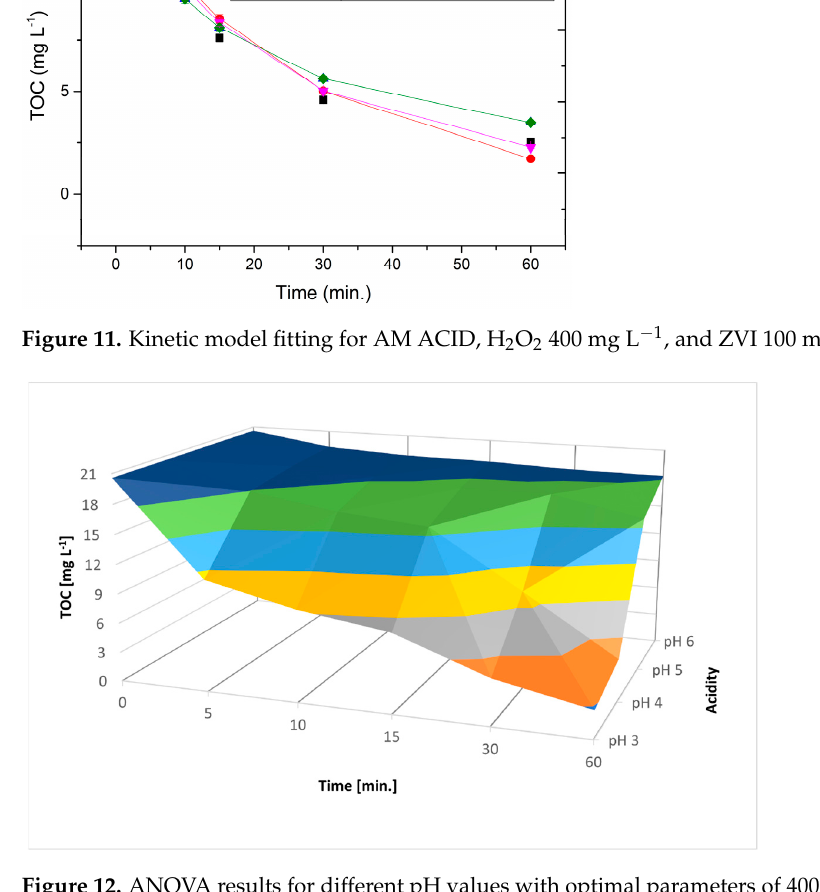
Figure 11. Kinetic model fitting for AM ACID, H 2 O 2 400mg L − 1 , and ZVI 100 mg L − 1 .